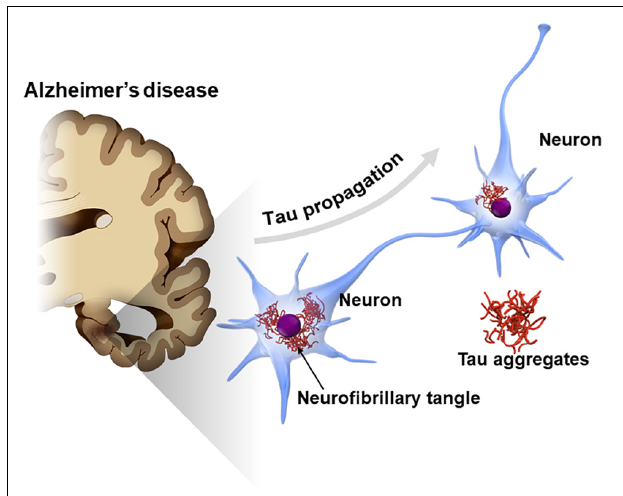
FIGURE 1 | Propagation of tau pathology in Alzheimer’s disease (AD) brain. The tau pathology in the AD brain [neurofibrillary tangles (NFTs)] is known to spread along a neural network in a stereotypical manner. Interneuron transfer of the pathological form of tau may underlie the stereotypical progression of AD neuropathology (tau propagation